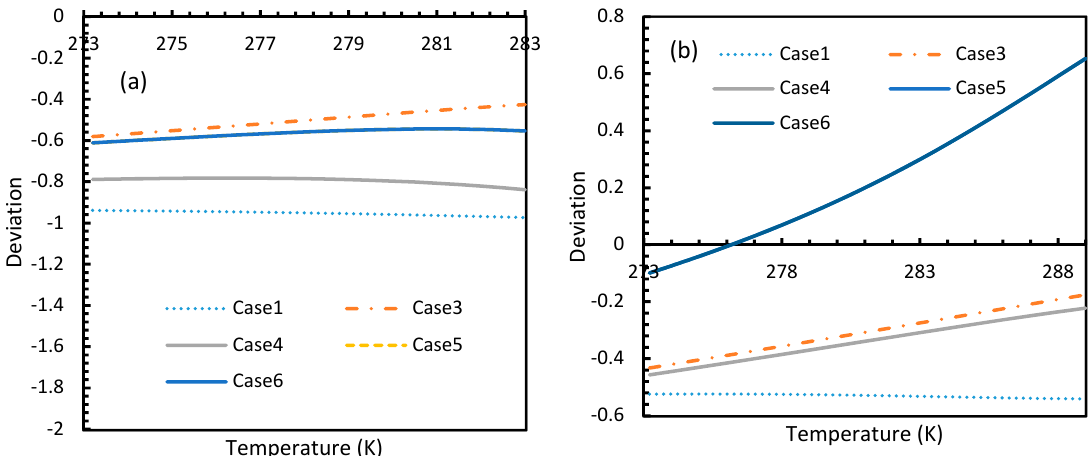
Figure 19. Profiles of deviations of theoretical induction times of CO 2 ( a ) and CH 4 ( b ) under isobaric conditions with reference pressure 30 MPa, calculated through the considered cases, apart from Case 6, from Case 2. Similar to Figure 17, the shapes of the profiles look like the inverted deviation profiles of nucleation rates and concentration of guest gas in aqueous phase only differing in quantitative perspective. The point of differentiability is pronounced by Cases 4, 5 and 6. A tendency of crossing over into positive deviation at higher temperatures can be observed in Case 5 and 6 when CO 2 was used. However, a full crossover can be seen at approximately 277 K, when CH 4 was used.